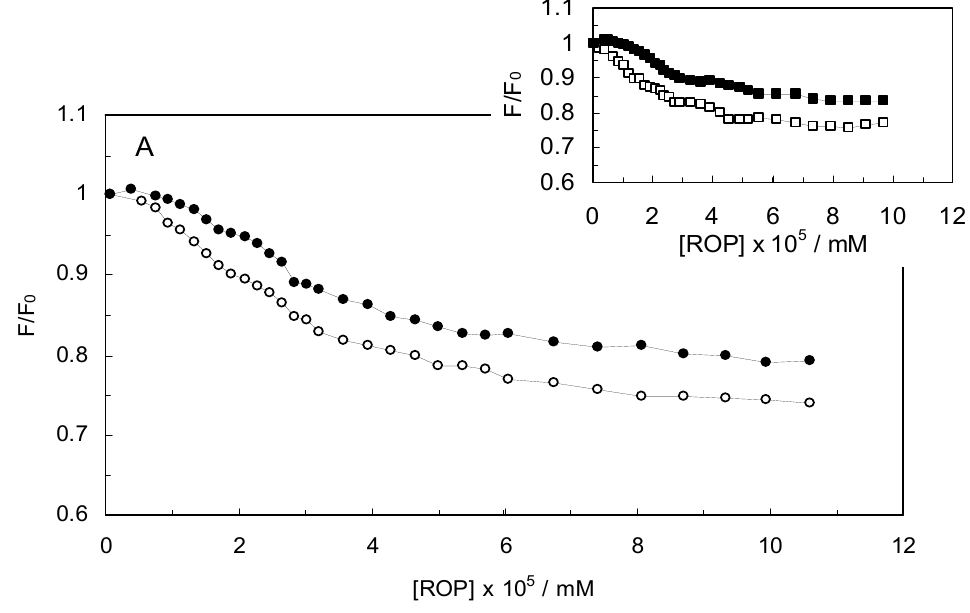
Figure 5. ( A ) Synchronous fluorescence spectra of the quenching of hTf by ROP. ( ○ ) ∆λ = 15 nm and ( ● ) ∆λ = 60 nm. Inset (A) Synchronous fluorescence spectra of the quenching of hTf by ROP in the presence of ASA. ( □ ) ∆λ = 15 nm and ( ■ ) ∆λ = 60 nm; ( B ) Synchronous fluorescence spectra of the quenching of hTf by ASA. ( ∆ ) ∆λ = 15 nm and ( ▲ ) ∆λ = 60 nm. Inset (B) Synchronous fluorescence spectra of (hTf-ROP)-ASA system. ( □ ) ∆λ = 15 nm and ( ■ ) ∆λ = 60